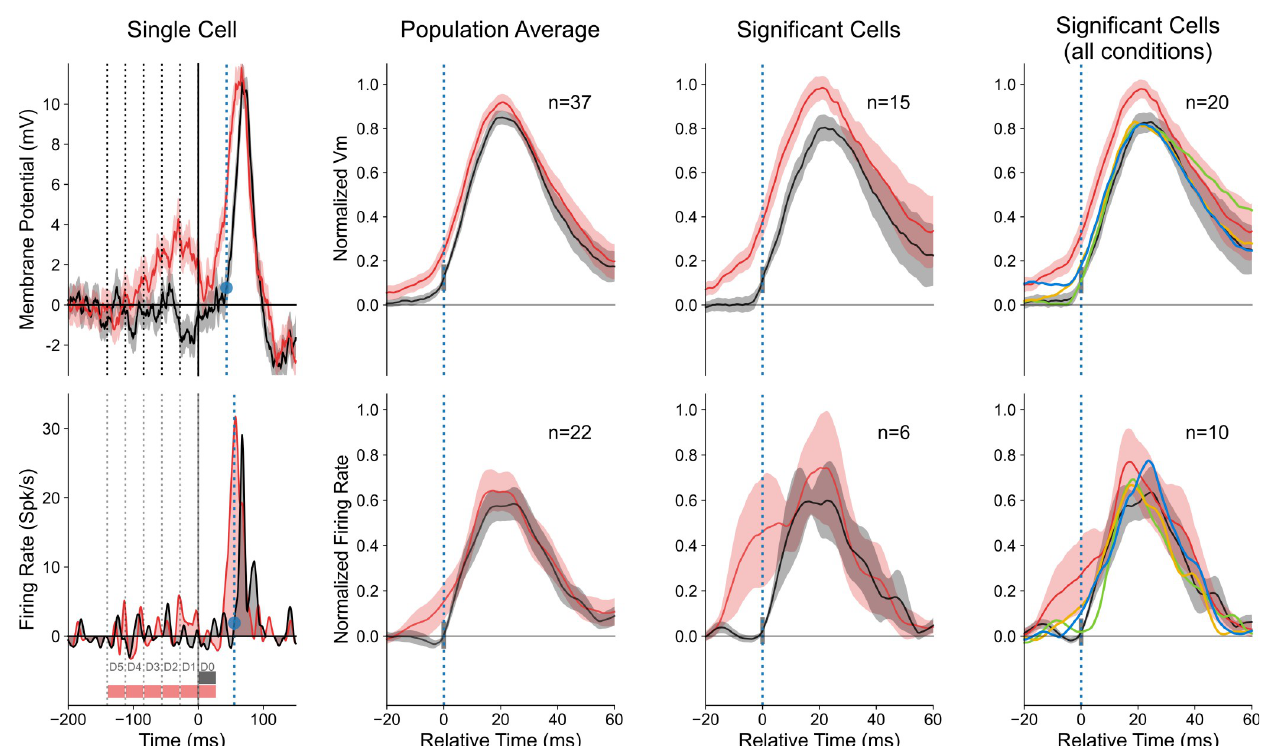
Fig 8. Contextual gain control induced by centripetal-ISO AM flow (“radial” protocol). Top row, subthreshold response (Vm); Bottom row, firing rate response (spikes/s). The first three columns, from the left illustrate the boosting effect produced by a CP-ISO AM sequence (red curve, Surround-then- Center) when compared to the response to the test GP inducer flashed in the RF Center (black curve, Center-Only). The local orientation of the GP inducers in the Surround and the global AM axis are co-aligned with the RF orientation preference. The last (right) column focuses on contextual dependency of the effect. From left to right, first column: Single cell example, where the vertical dotted gray lines indicate the respective timing of each peripheral stoke stimulation at successive eccentricities (from D5 to D1), whereas the continuous vertical gray line indicates the onset of the “Center-Only” test stimulation (D0). The blue dot and corresponding dotted line give the latency of the first point in time where the Center-Only response departs significantly from the resting state (p < 0.01). Second column from the left, population averages for the CP-ISO (red) and the Center-Only (black) conditions. Averaging is done in two steps, first across trials for each cell for the same context condition, then across cells after realigning individual mean waveforms around a common onset latency, that of their Centre-Only response (“0” mark of the “Relative Time” abscissa, blue points in left panels). Response amplitudes are normalized relatively to the peak of the “Center-Only” response. The third column illustrates the population average profile of individual cells showing either significant positive latency advance, response integral increase, or both, compared to the center-only test control (permutation test, 104 repetitions, p < 0.05). The difference in rising phases and onset latencies between the CP-ISO (red) and Center-Only (black) responses are shown on an expanded time basis. The mean ± SEM value envelopes are respectively illustrated by a continuous curve and a shaded area. Right column , the statistical significance analysis is extended to cells which showed significant “Surround-only” responses (subthreshold: n = 20; spiking: n = 10). Color code, same as in Fig 1: For the SECTOR configuration, red for CP-ISO, green for CF-ISO, gold for CP-CROSS. For the FULL configuration, blue for CP-RND-ISO. The contextual averages show that CP-ISO (red) is the only condition where a change in onset latency is observed, both at the Vm (top) and spiking